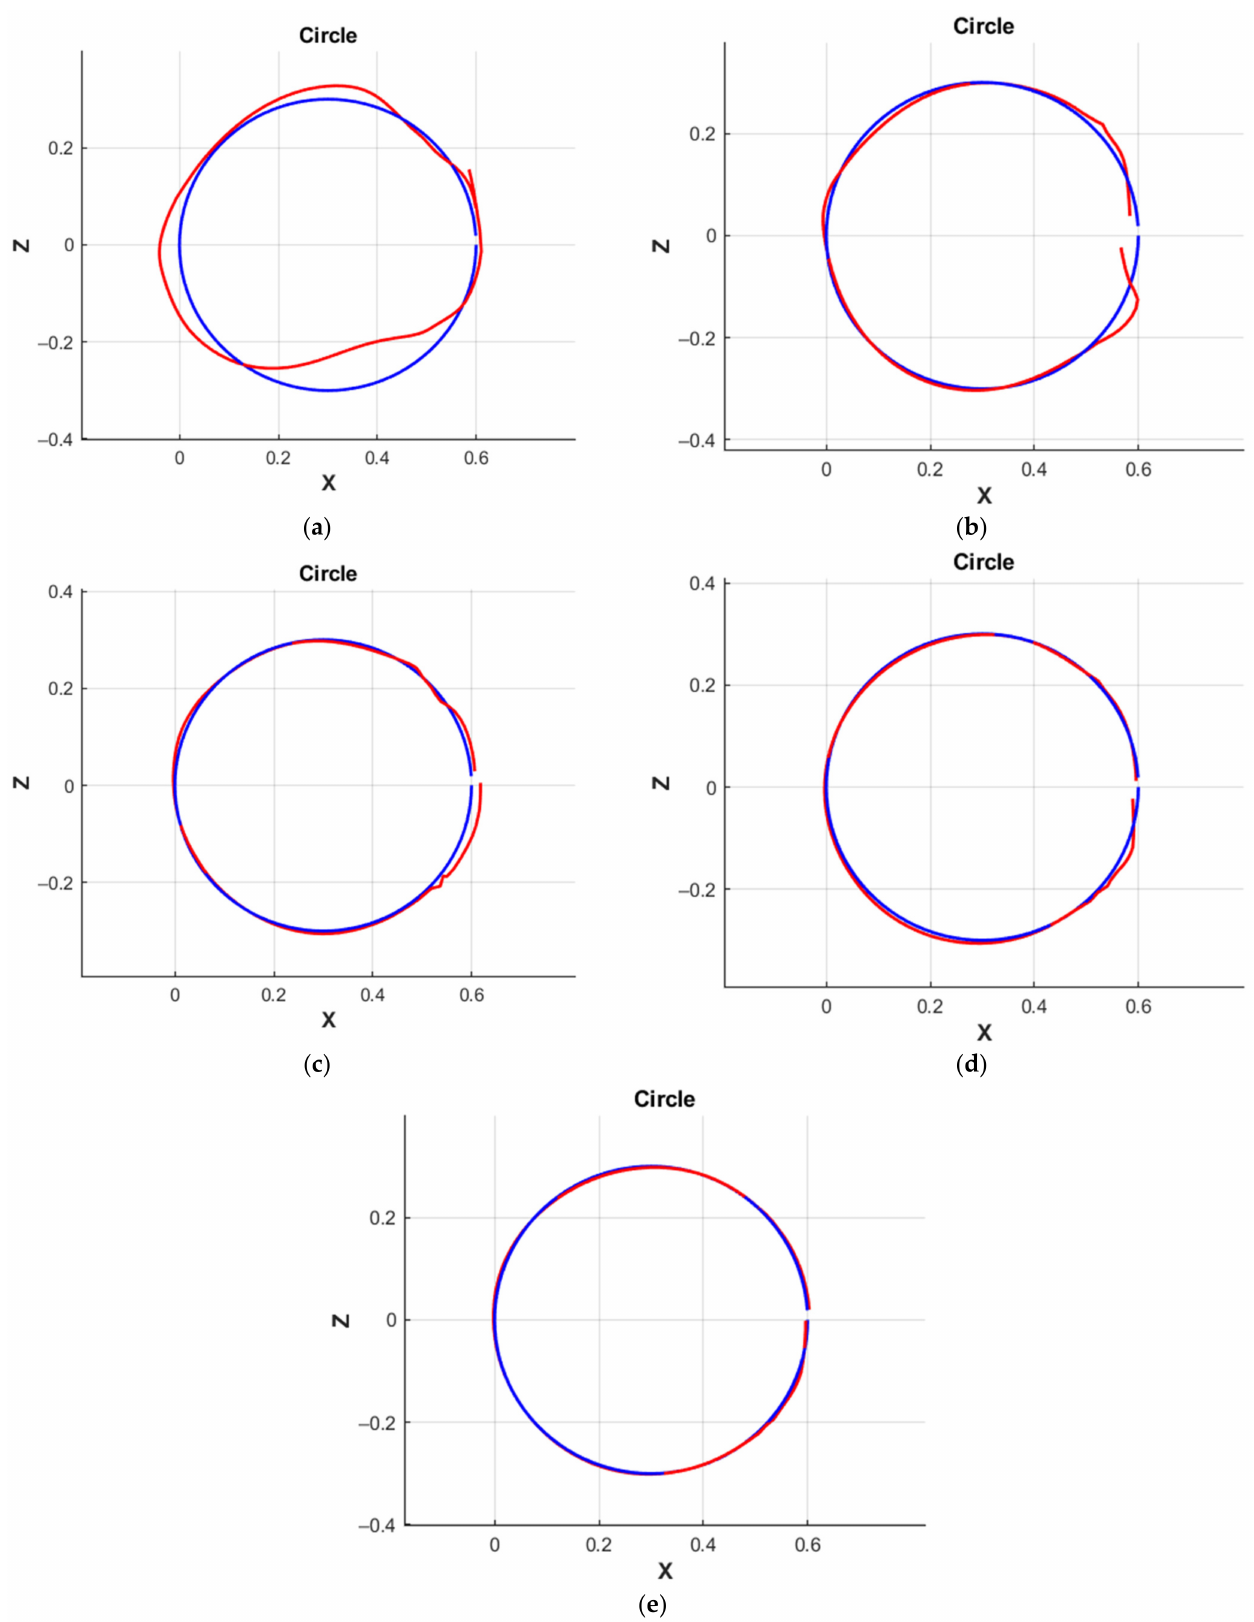
Figure 13. Simulation of the movement of the manipulator along a circle: ( a ) MATRIX NN 1; ( b ) MATRIX NN 2; ( c ) MATRIX NN 3; ( d ) MATRIX NN 4; ( e ) the correctional